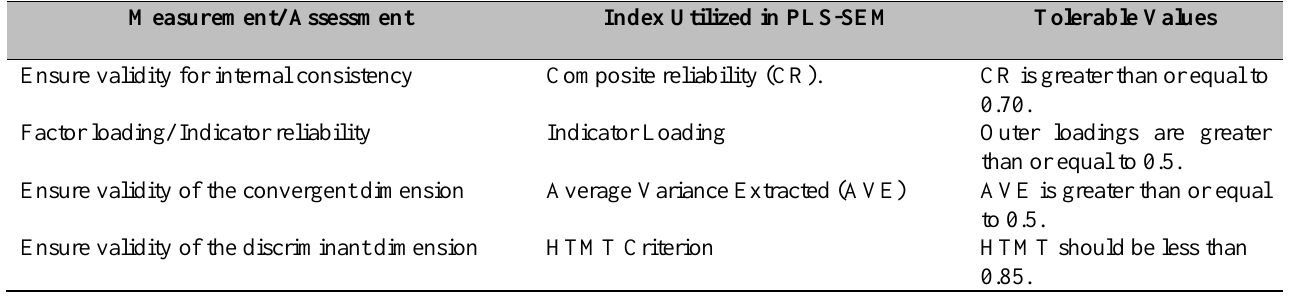
Acceptable Values for Model Evaluation- Measurement Model Analysis